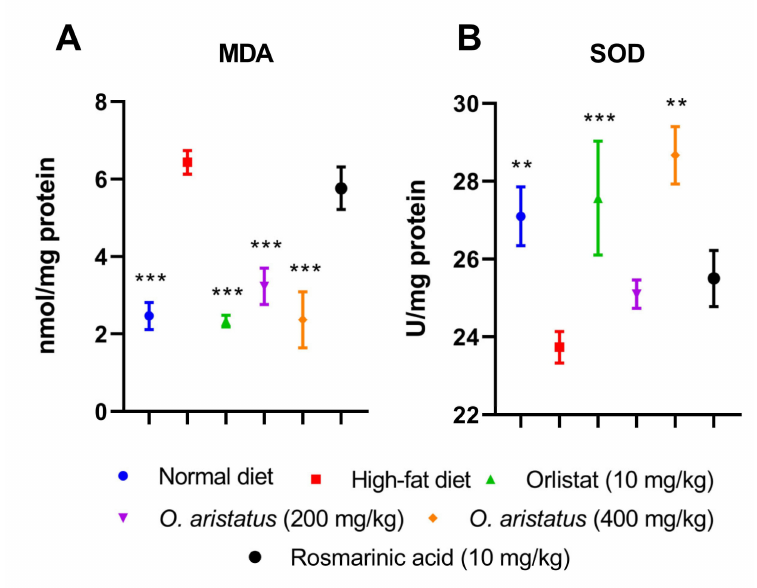
Figure 7. The effect of O. aristatus on the malondialdehyde (MDA) and superoxide dismutase (SOD). * p < 0.05, ** p < 0.01, *** p ≤ 0.001 compared to high-fat diet group. Values were presented as mean ± SD, n = 5.